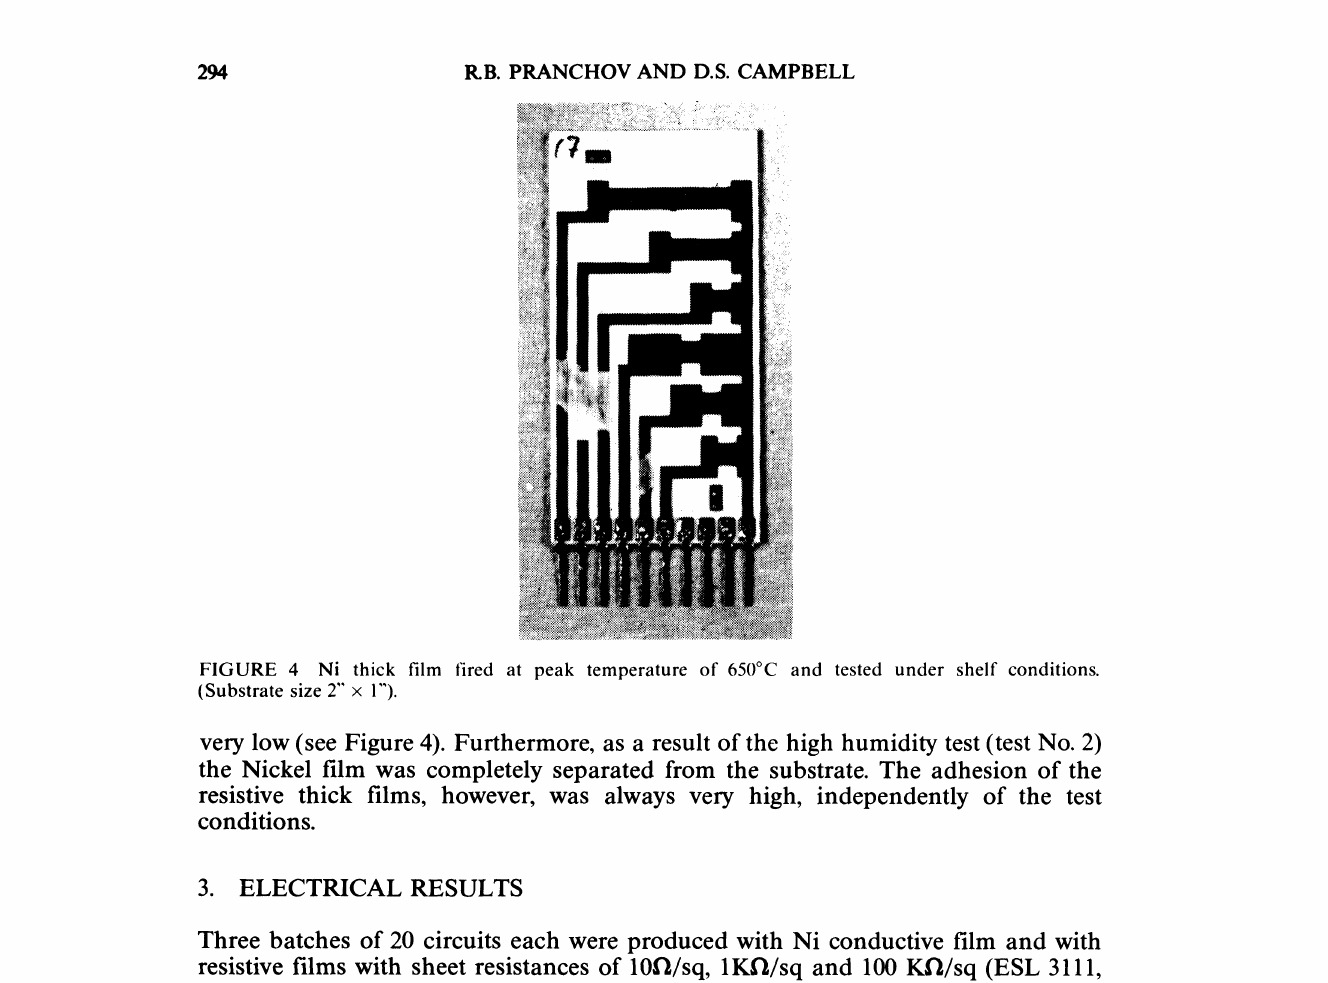
TABLE III Results of resistance